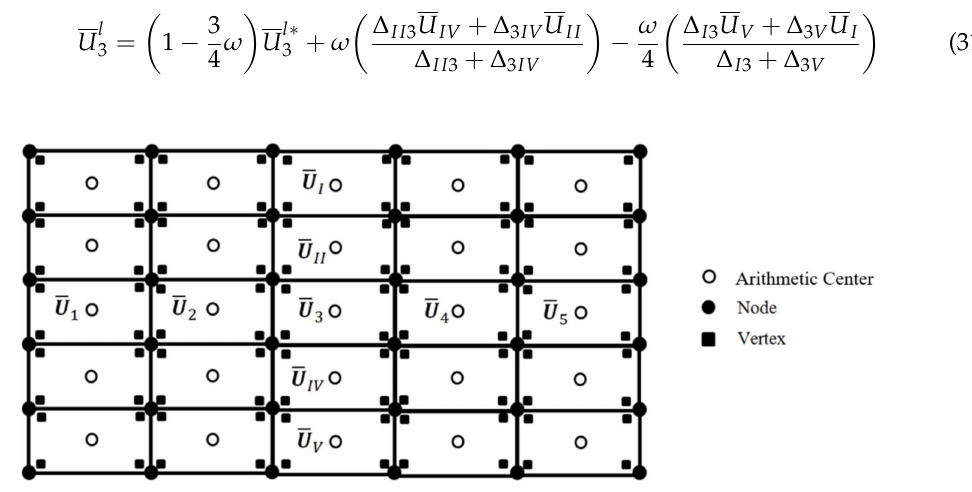
Figure 1. Discretization using discontinuous linear rectangular elements.